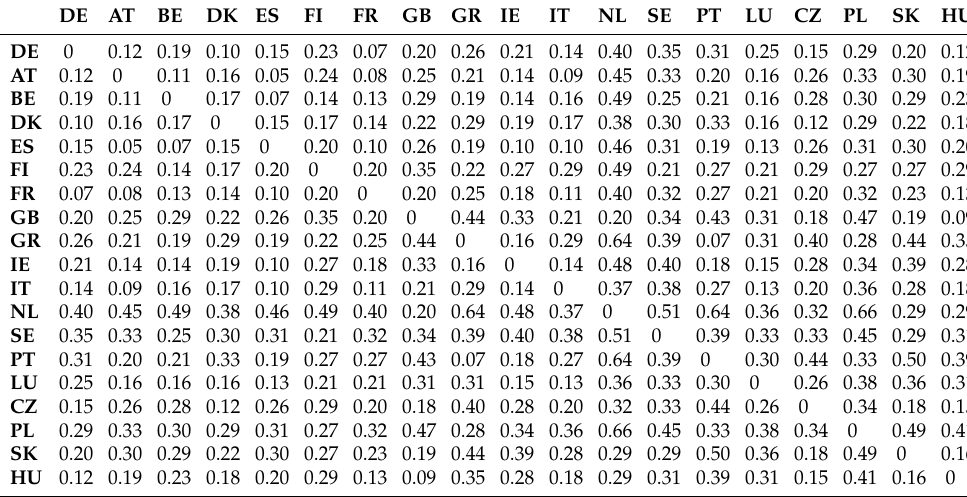
Table A1. Structure diversity matrix of energy use sources in the food production systems in 2000–2001 ( γ = 0.22).